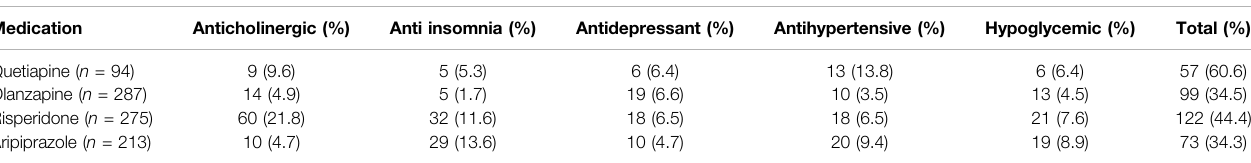
TABLE 3 | Concomitant medications of four antipsychotics.